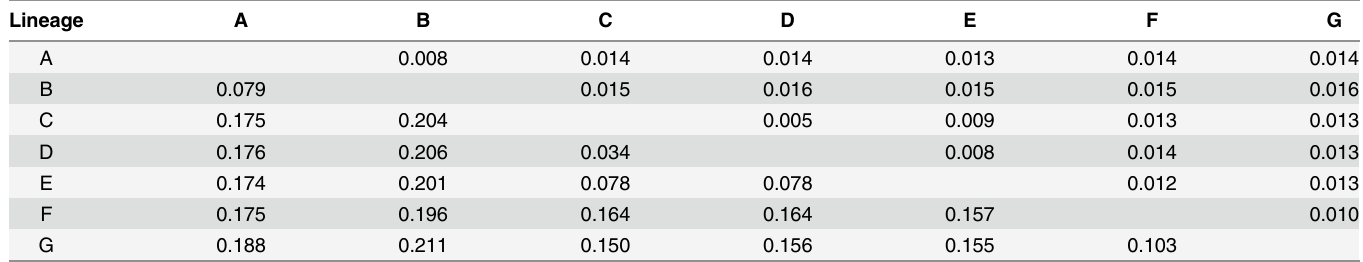
Table 3. Mean genetic distances among different lineages of O . schmackeri species complex based on the Kimura 2-parameter model (lower-left), standard error (upper-right) estimated by bootstrap method (replication = 1000).